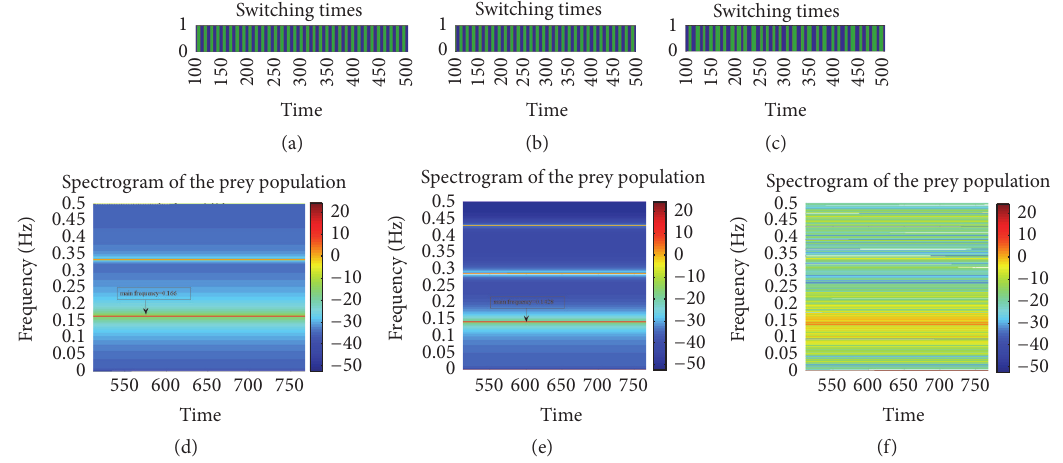
Figure 6: Switching times and switching frequencies; (a–c) switching times and (d–f) switching frequencies. The parameter values are fixed as follows: 𝑝 = 0.1, 𝜏 = 0.3, 𝜎 = 0.66, 𝛽 = 4, 𝛿 = 2.0 ,andET = 0.6. (a,d) 𝛼 = 3 ;theinitialdensityofpreyandpredator (𝑥 0 , 𝑦 0 ) = (0.4,0.15) .(b, e) 𝛼 = 3 ; the initial density of prey and predator (𝑥 0 , 𝑦 0 ) = (0.52, 0.2) . (c, f) 𝛼 = 3.5 ; the initial density of prey and predator (𝑥 0 , 𝑦 0 ) = (0.8, 0.2) ; the color bar at the right tells us that the deeper red represents the frequencies where the power spectrum is highest.